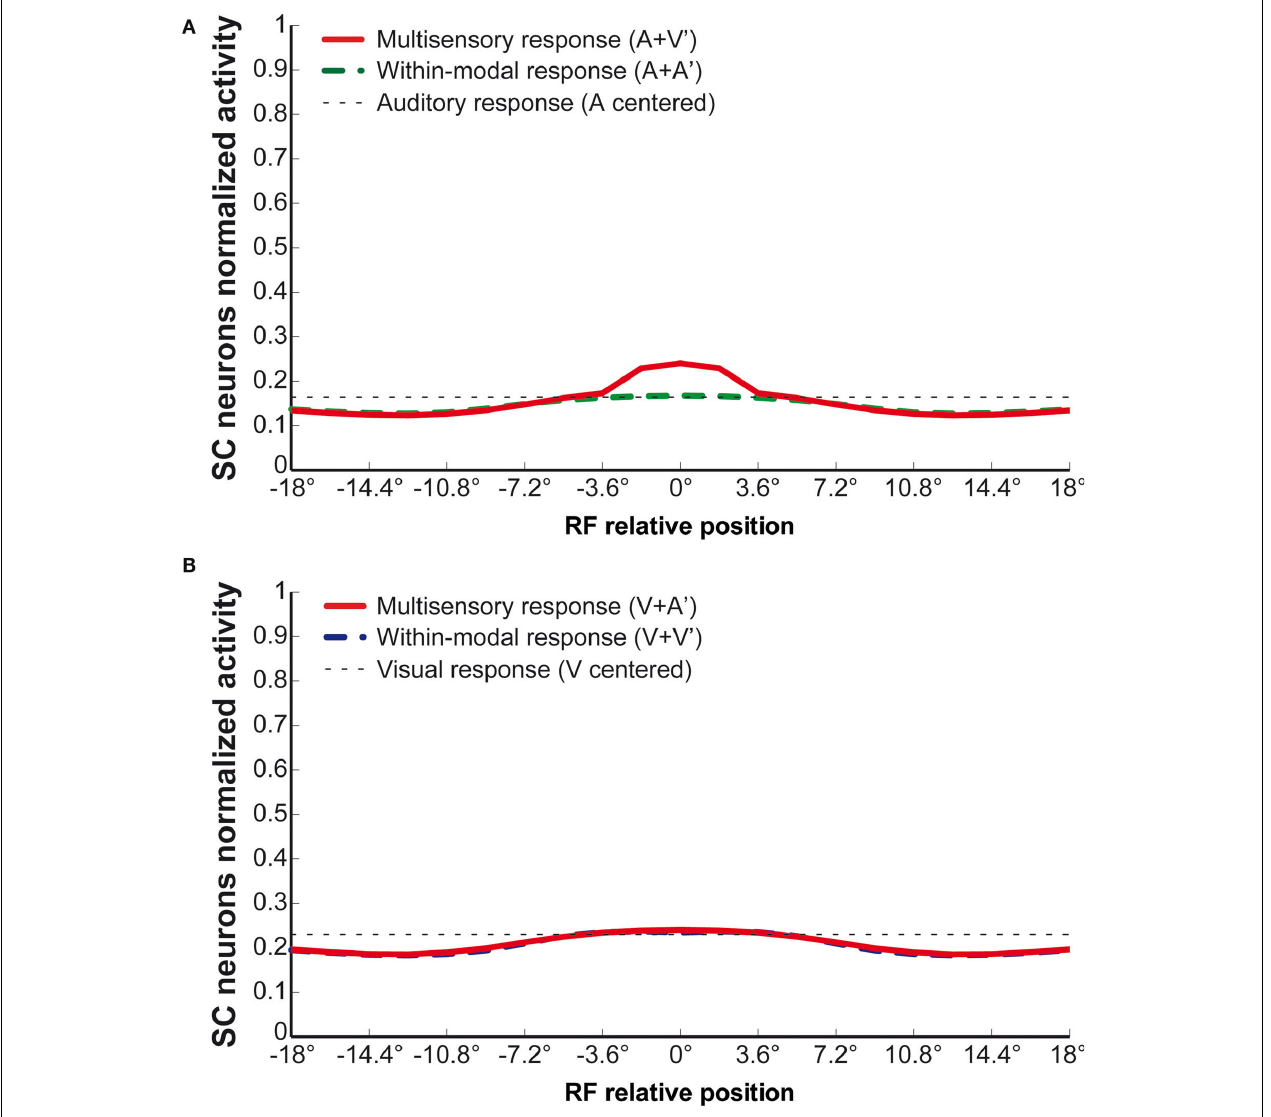
FIGURE 6 | The effect of AES on integration. The same simulations as in Figure 3 performed after inactivation of AES. Results show: (1) a reduction in the SC response both to a unisensory and to a multisensory stimulation; (2) the loss of multisensory enhancement in case of cross-modal stimulation inside the RF: the response of the network looks like the one elicited by the strongest unisensory input; (3) a slight inhibition in case of two stimuli of the same or different sensory modality far in